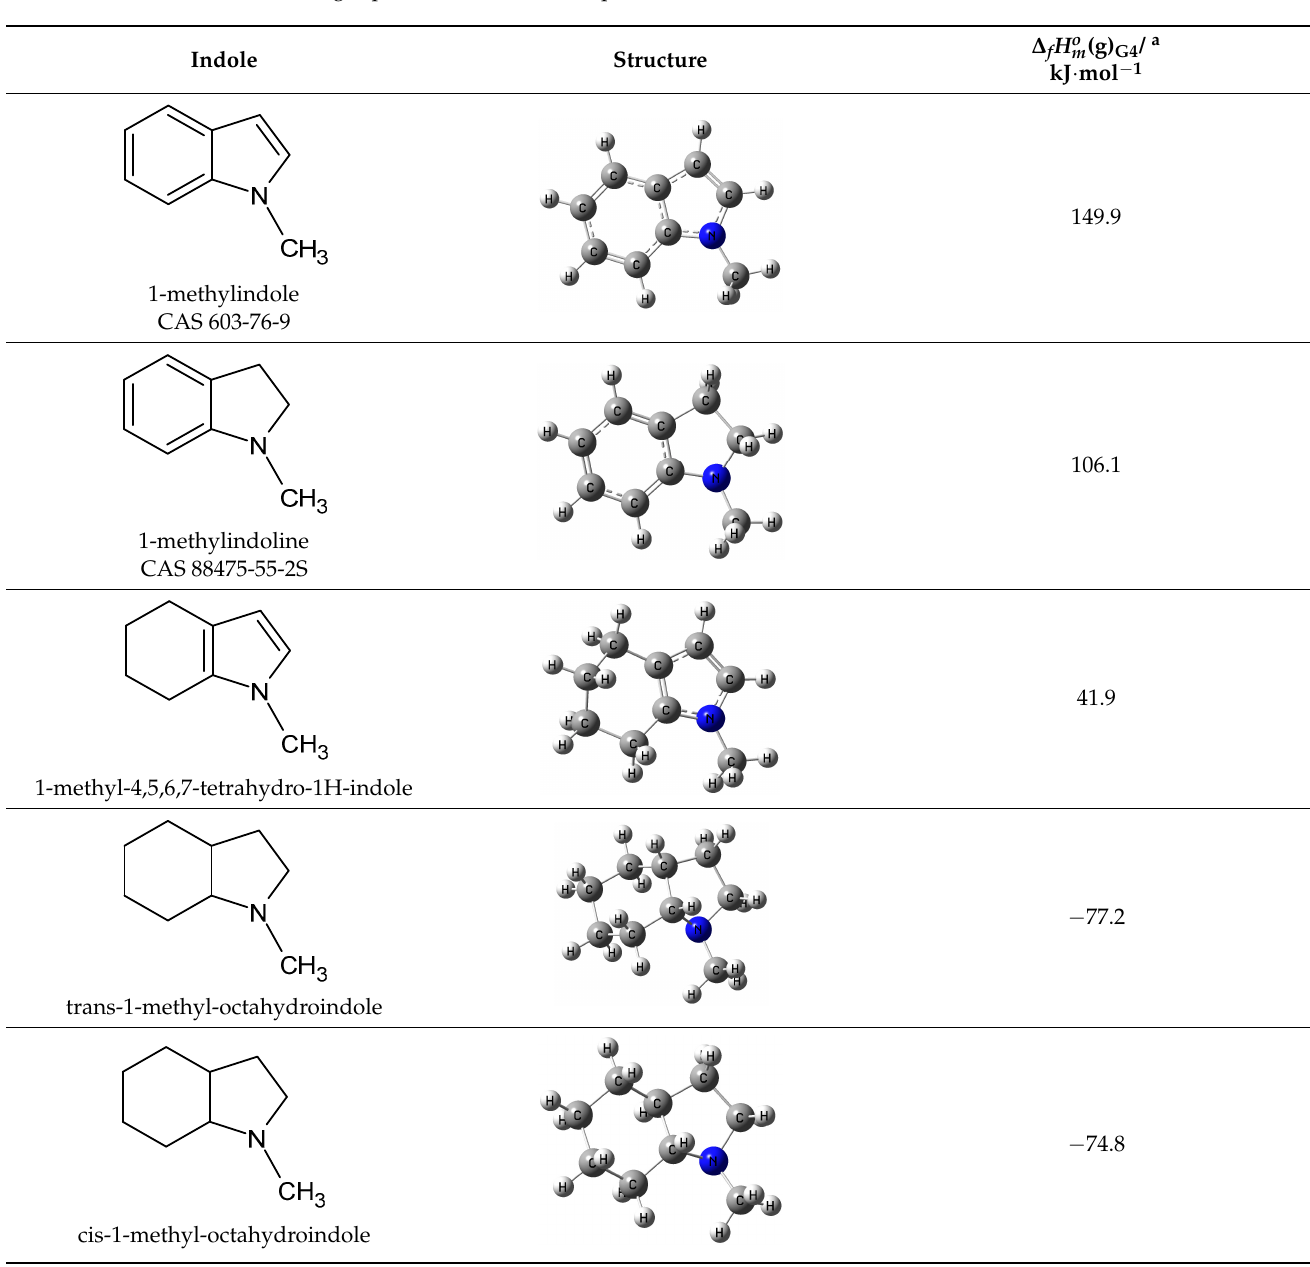
Table 6. Theoretical gas-phase enthalpies of formation ∆ (cid:2916) 𝐻 mo (g) at T = 298.15 K ( p° = 0.1 MPa) for indole derivatives as calculated by different methods (in kJ·mol − 1 ).